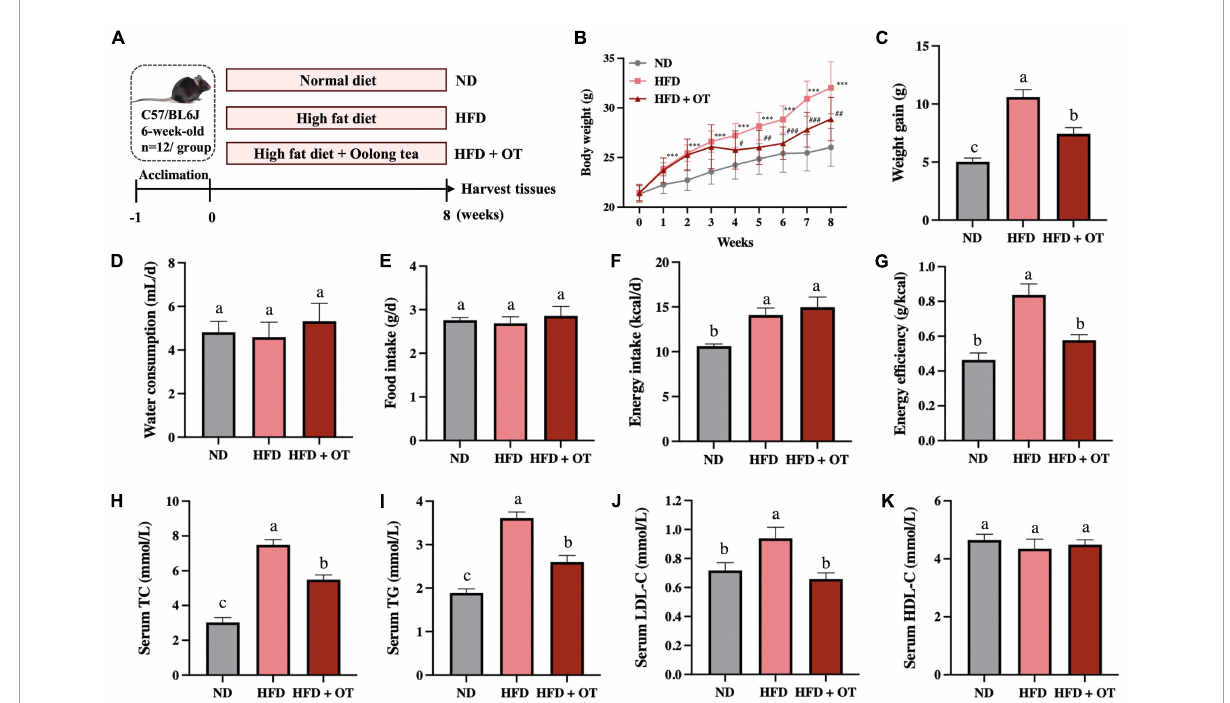
FIGURE1 Oolong tea reduced overweight and dyslipidemia in HFD-fed mice. (A) Schematic overview of the animal experiment. (B) Body weight throughout the 8-week intervention. (C) Body weight gain. (D) Average daily water consumption. (E) Average daily food intake. (F) Energy intake. (G) Energy efficiency. (H) Serum TC levels. (I) Serum TG levels. (J) Serum LDL-C levels. (K) Serum HDL-C levels. Data are expressed as mean ± SEM ( n = 12). (A,C–K) The mean value with different letters indicates significant differences ( p < 0.05). (B) HFD vs. ND: ∗∗∗ p < 0.001; OT vs. HFD: # p < 0.05, ## p < 0.01, ### p <